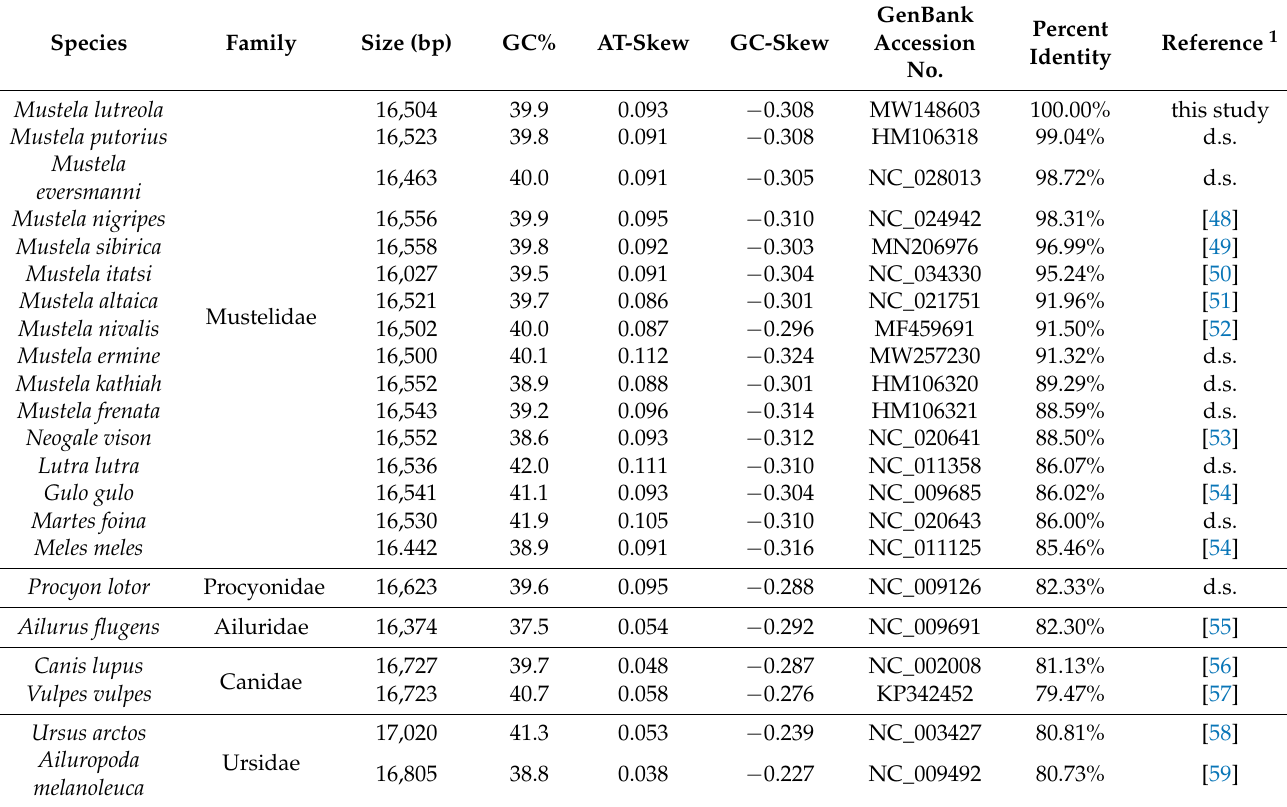
Table 5. Comparison of the basic features of the mitochondrial genomes of Mustela lutreola and other members of the Caniformia